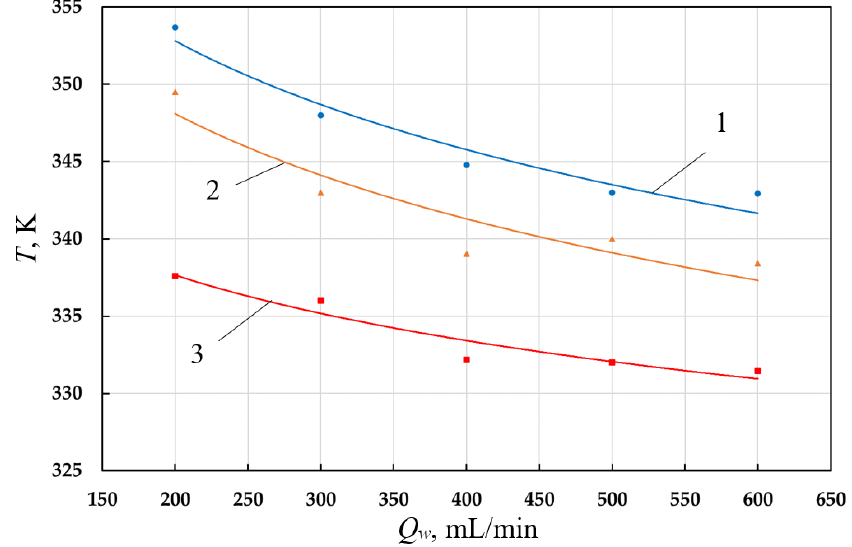
Figure 5. Dependence of the valve plate temperature on the coolant flow rate (1— p d = 0.7 MPa; 2— p d = 0.5 MPa; 3— p d = 0.3